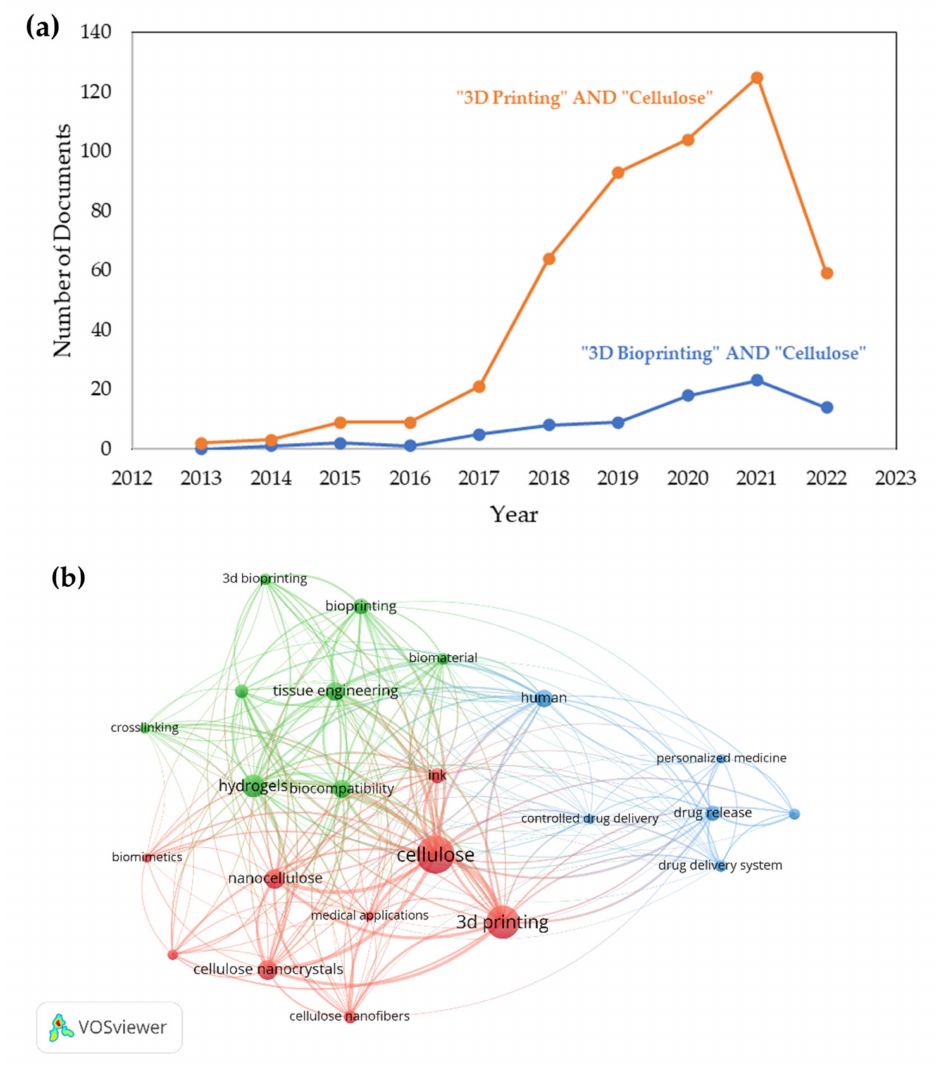
Figure 8. ( a ) Publication of article by year (Source: www.scopus.com, accessed on 17 April 2022) and ( b ) the co-occurrences analysis by all